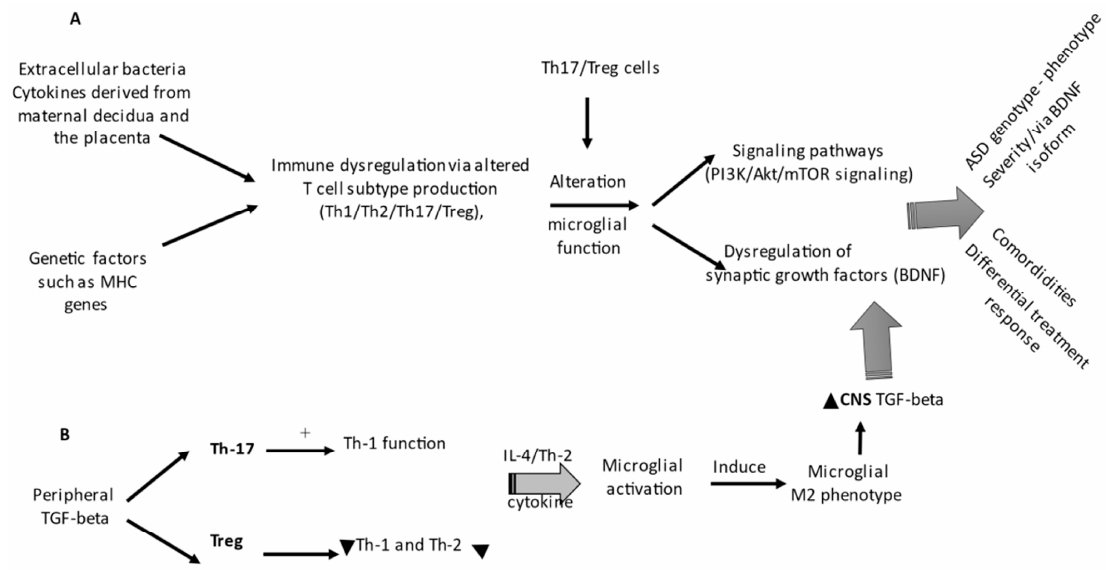
Figure 2. Immune dysregulation, ASD phenotypes, and treatment responses. ( A ) Soluble mediators from direct transfer across the placenta target the fetal brain and induce behavioral outcomes, differential phenotypes, and drug response in autism. ( B ) T cell subpopulations influencing microglial functioning drive synaptic growth factors, dysregulation, and signaling pathways (such as mTOR), contributing to differential clinical ASD phenotypes and treatment responses. The figure has been drawn using Power Point 2013.